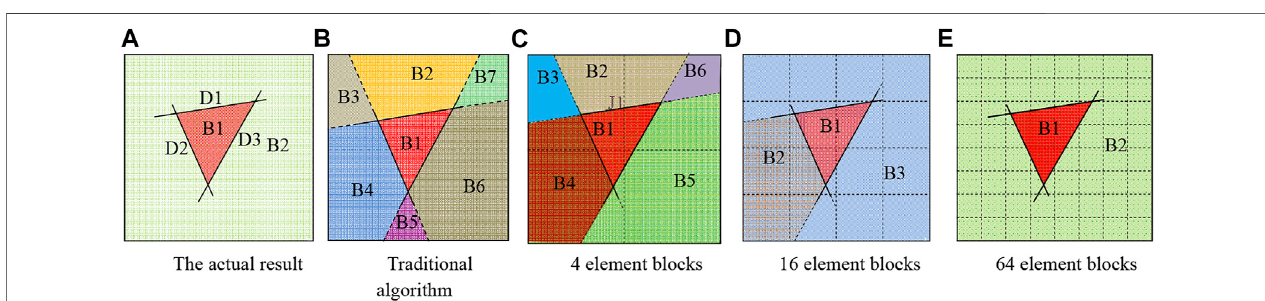
Frontiers in Earth Science |